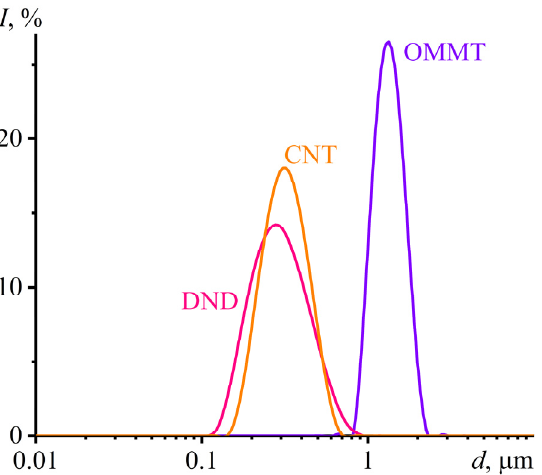
Figure 8. Size distribution of particles by scattering intensity in their 0.1% dispersion in epoxy resin.